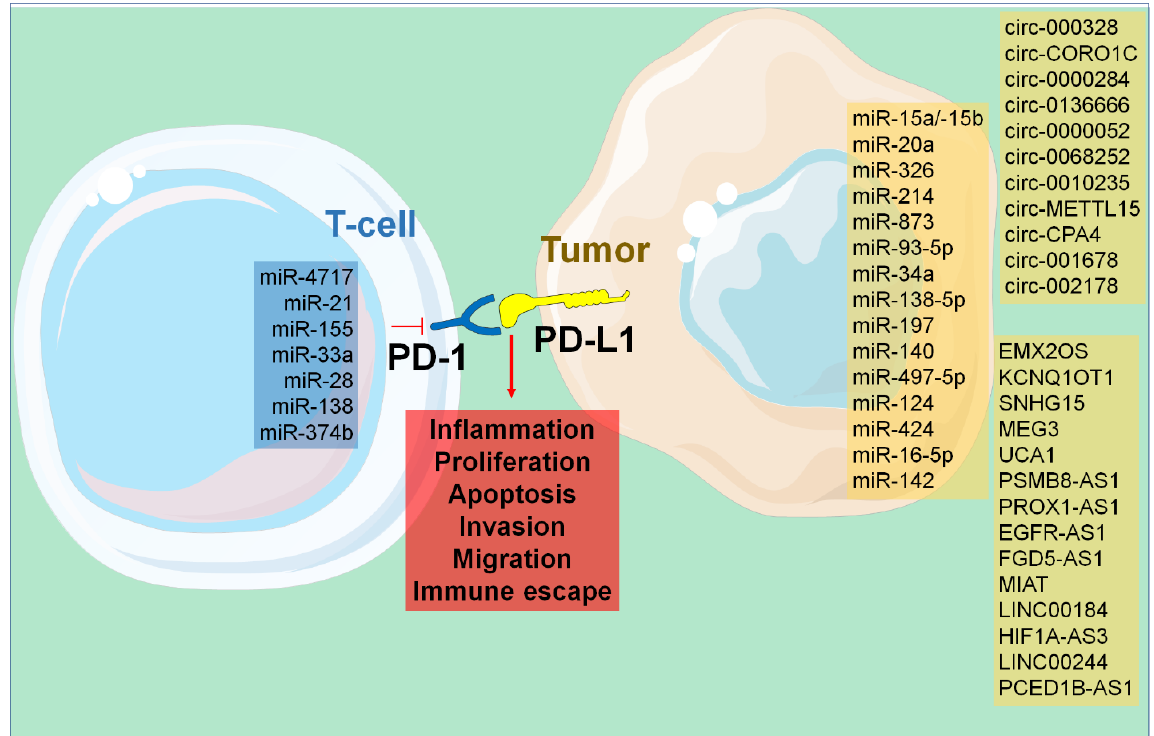
Figure 2. Cellular processes governed by the activation of PD-1/-L1 and -L2.